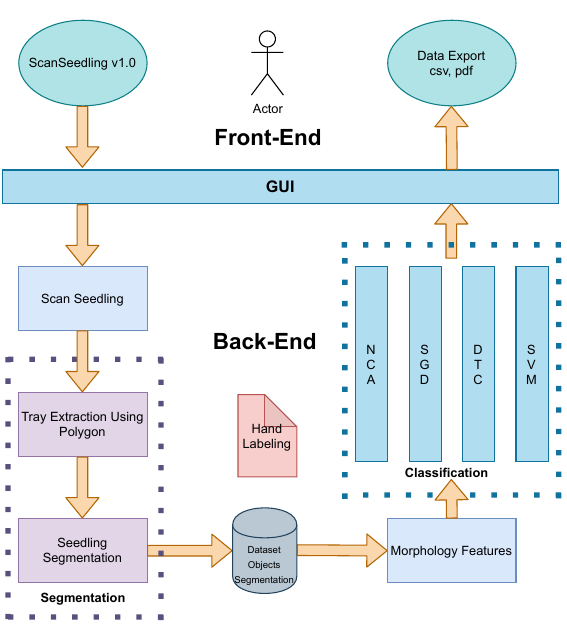
Figure 2. The methodology is divided into six stages: 3D seedling scanning, tray point cloud extraction, seedling segmentation, height and development features extraction, seedling classification into four categories, and output